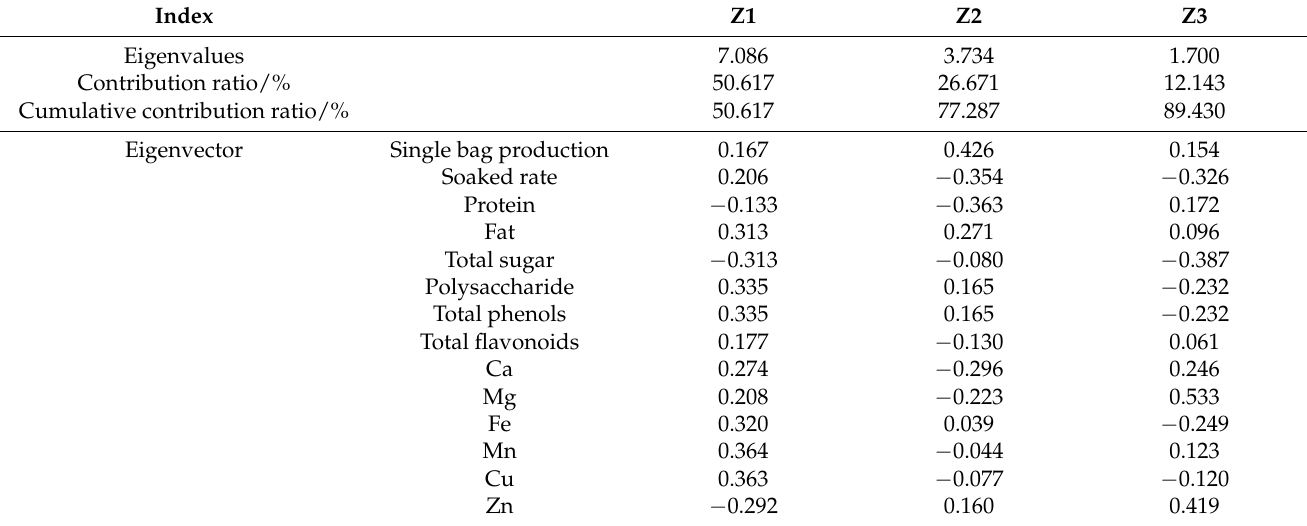
Table 5. Correlation between different walnut supplemental levels and growth index of A. auricula